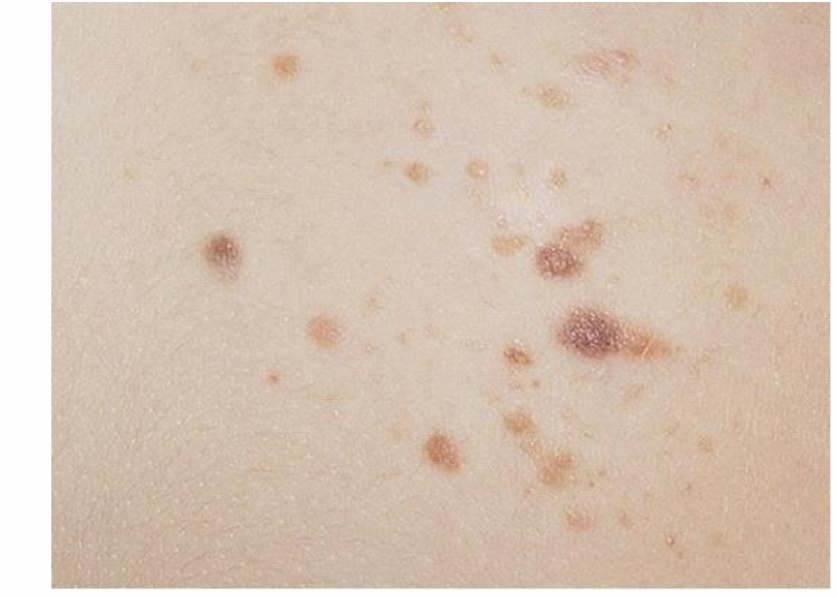
Figure 1. Pigmented